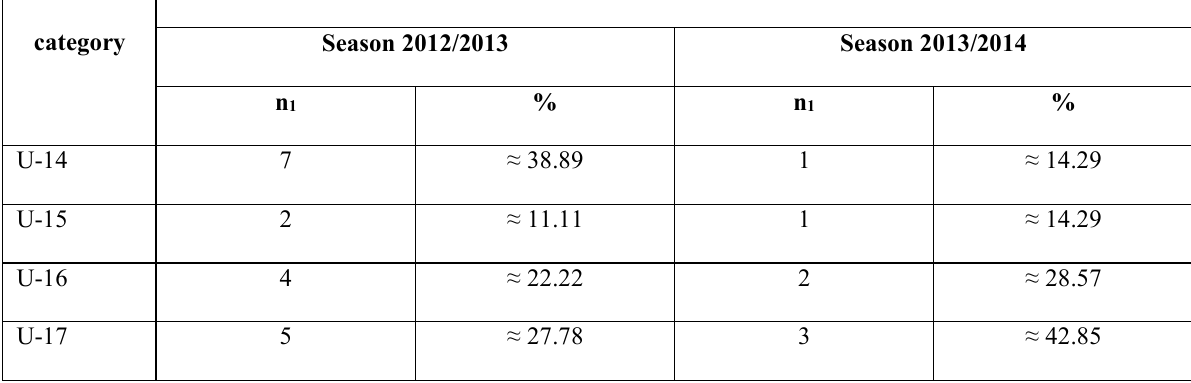
Quantitative and qualitative indicators of upper and lower limbs’ traumas of CJSS FC “Metallurg” (Zaporozhye) football players in seasons 2012/2013 and 2013/2014in performances in children-junior football league of